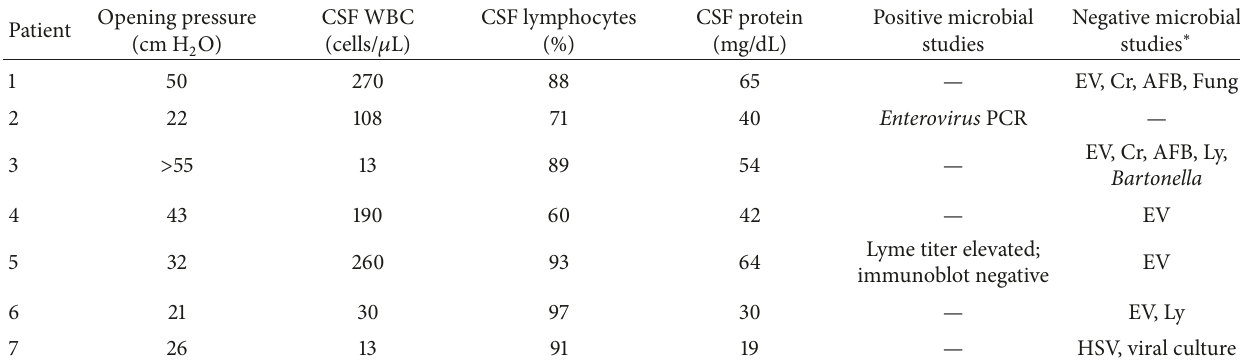
Table 2: Results of lumbar puncture and cerebrospinal fluid